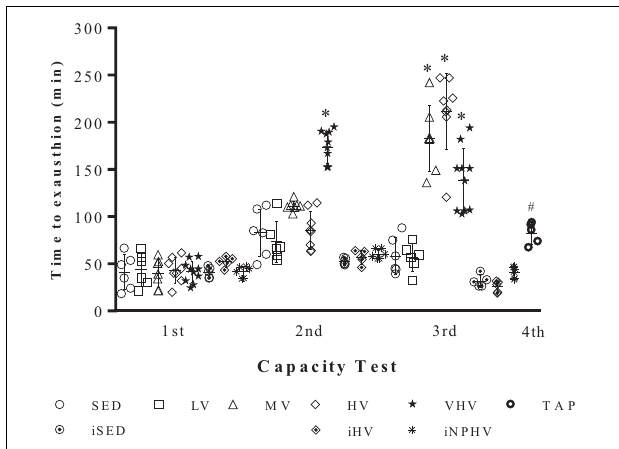
FIGURE 1 | Physical capacity tests (time to exhaustion in minutes) between different experimental groups before (1st), during (2nd), and after (3th) the 10-week training period and 2 weeks of active rest. Values expressed as mean ± SE ( ∗ P < 0.001). Groups: sedentary control (SED), low volume (LV), medium volume (MV), high volume (HV), very high volume (VHV), tapering (TAP), infect sedentary control (iSED), infected high volume (iHV), and infected non-periodized high volume